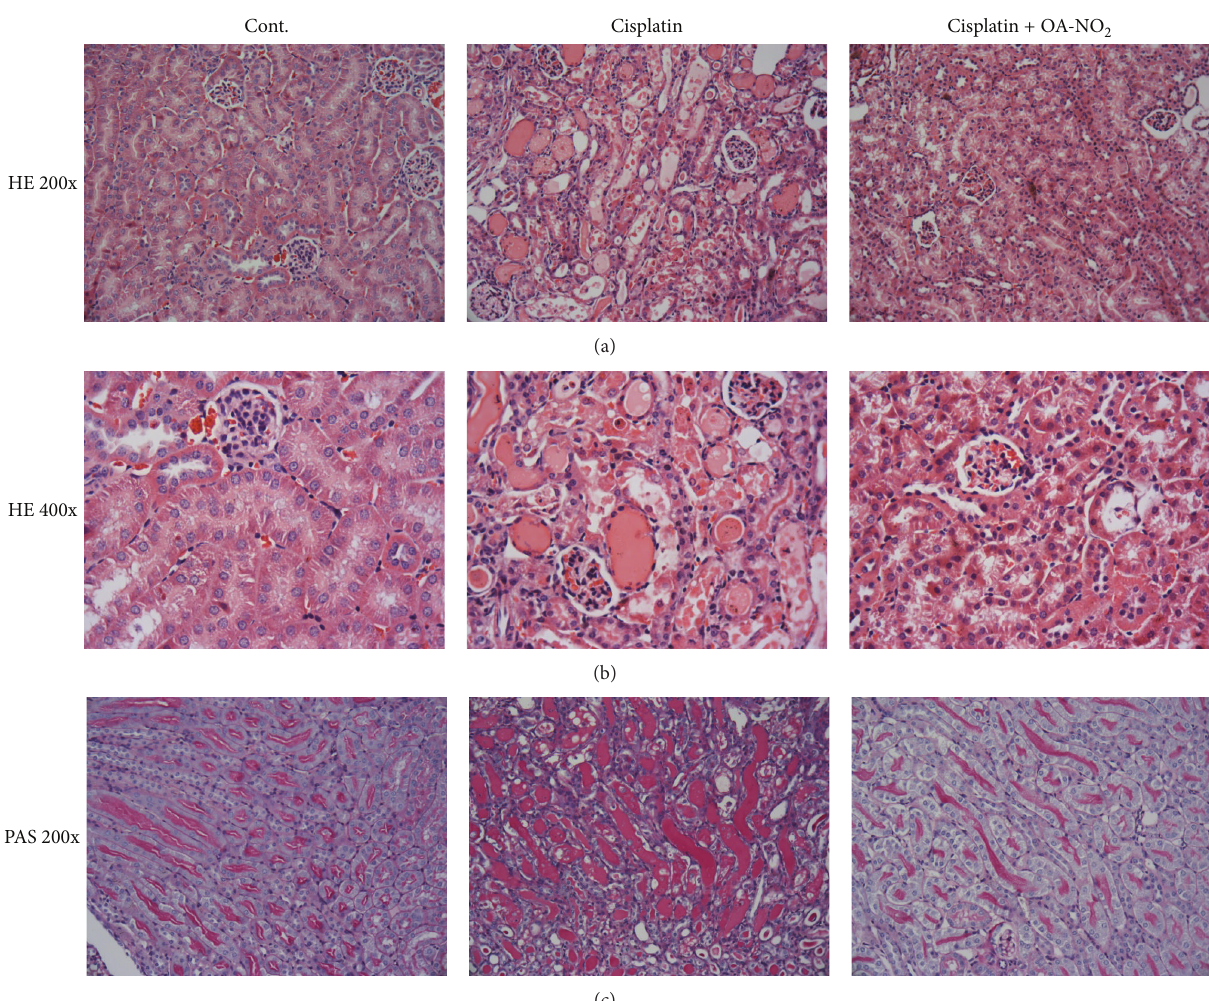
Figure 3: Morphological changes of cisplatin-induced renal injury in control, cisplatin vehicle, and cisplatin + OA-NO 2 mice. ((a)–(c)) Representative photomicrographs with hematoxylin and eosin staining (magnification of 200 and 400) and periodic acid-Schiff staining (magnification 200) of renal cortex of kidneys; Cont.: 𝑁 = 6 ; cisplatin: 𝑁 = 12 ; cisplatin + OA-NO 2 : 𝑁 = 13 . Data are mean ±